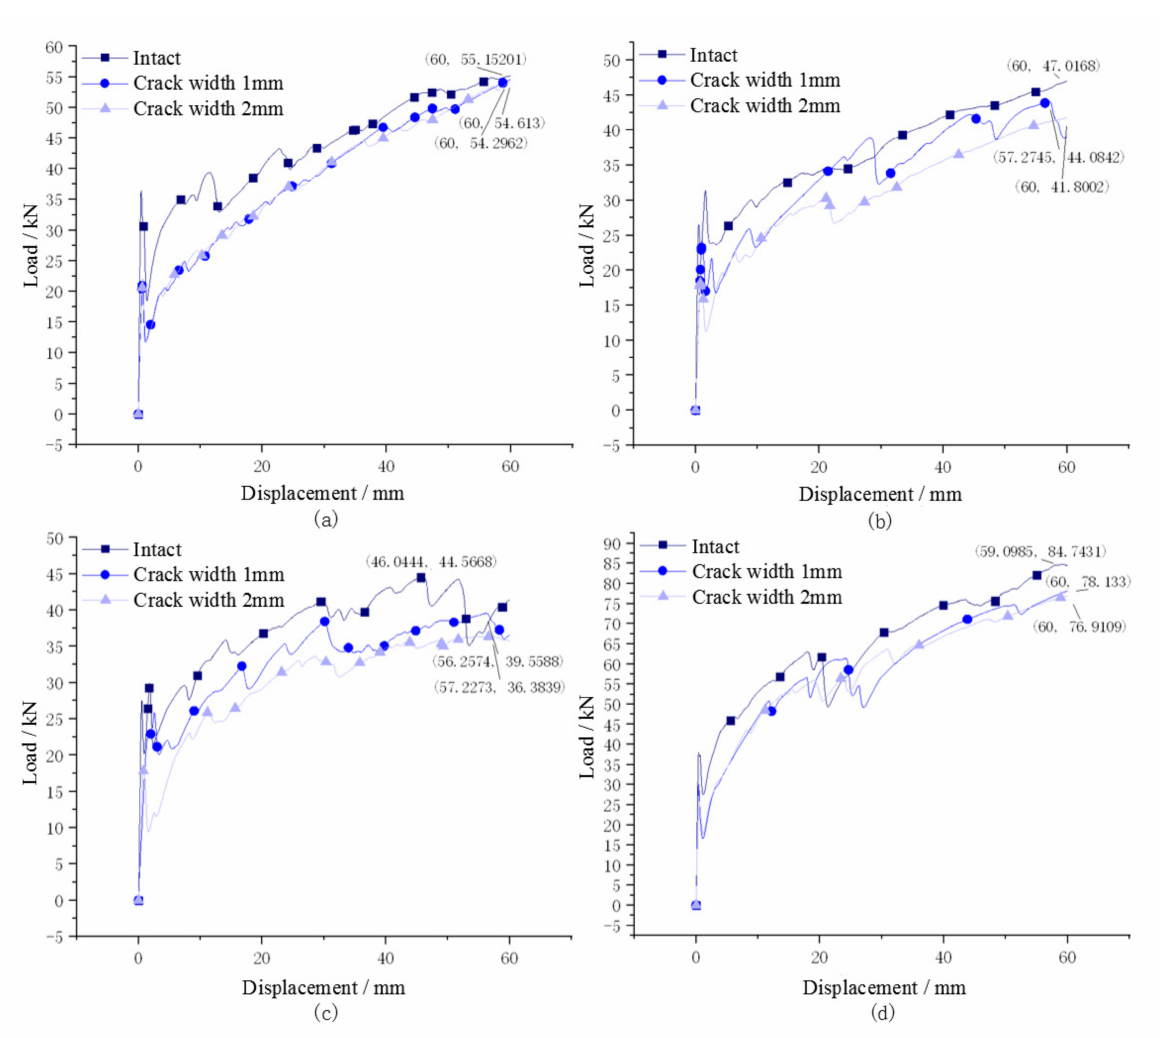
Figure 9. Effect of crack width on ( a ) circular; ( b ) rectangular; ( c ) arched; and ( d ) trenched cable